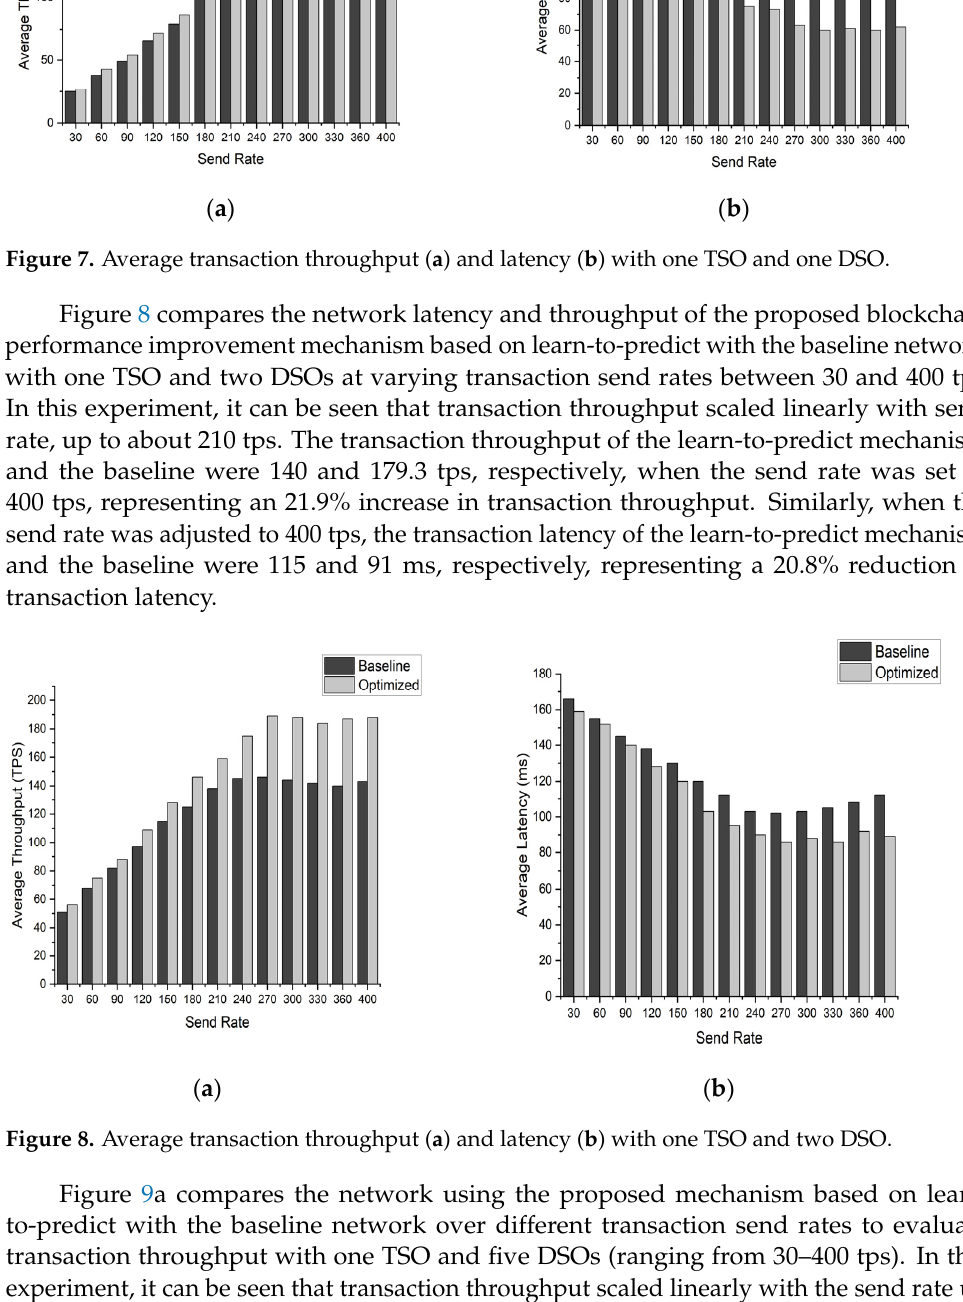
( b ) Figure 9. Average transaction throughput ( a ) and latency ( b ) with one TSO and five DSO. Figure 9b compares the network using the proposed transaction traffic control mech- anism based on learn-to-predict with the baseline network over different transaction send rates to evaluate transaction latency with one TSO and five DSOs (ranging from 30 to 400 tps). When the send rate was adjusted to 400 tps, the transaction latency of the learn-to-